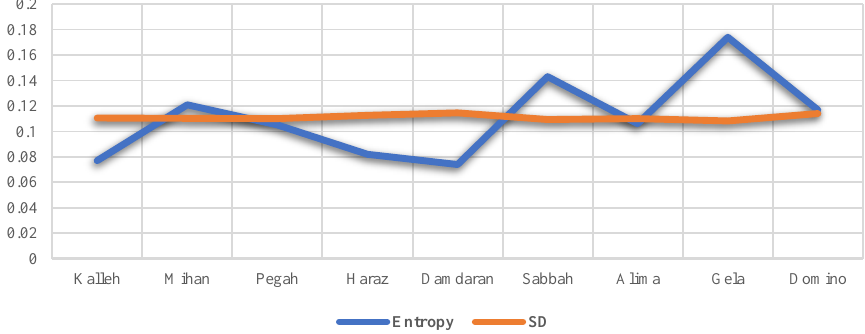
Figure 6. The comparison of SD and entropy in the case of stability computation: first suppliers ’ evaluation example.